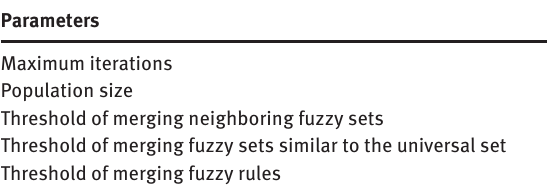
Table 1: The Control Parameters of